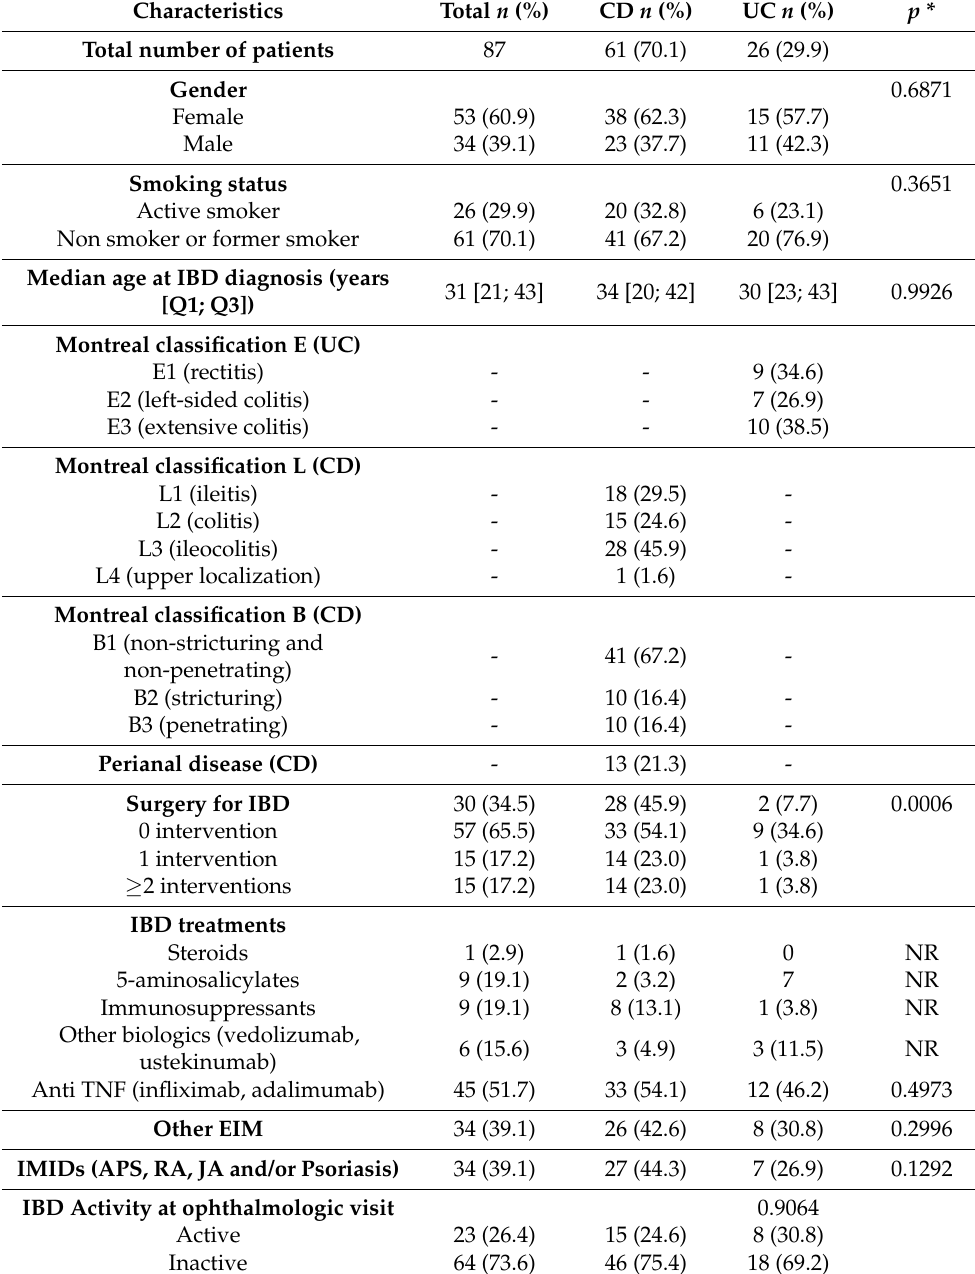
Table 1. Characteristics of